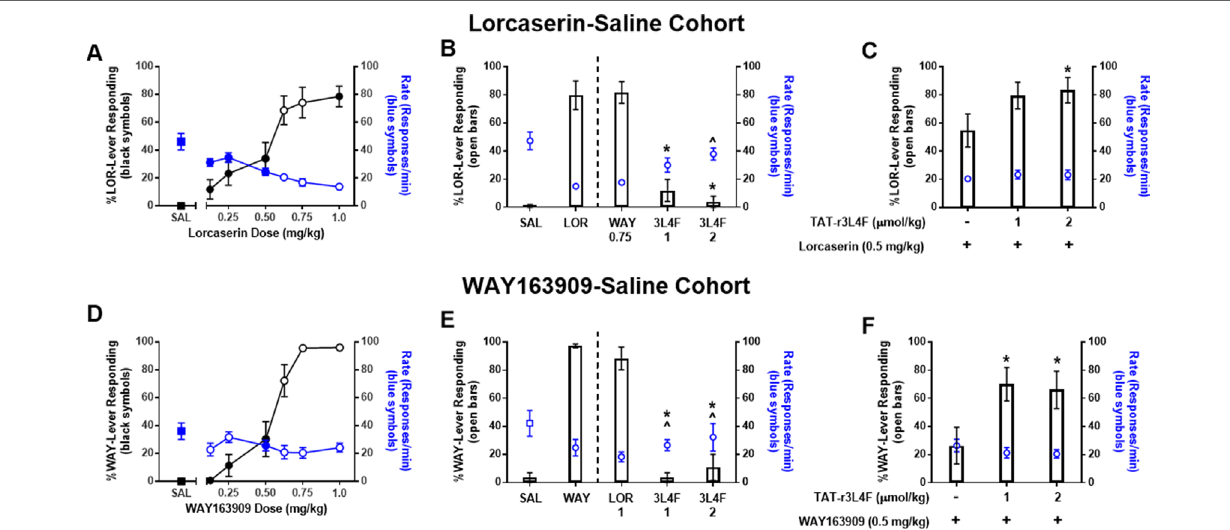
FIGURE 2 | Results of dose–response tests in (top) rats (n = 14) trained to discriminate lorcaserin (LOR; 0.75 mg/kg) from saline and (bottom) rats (n = 7–13) trained to discriminate WAY163909 (WAY; 0.75 mg/kg) from saline (SAL). Black symbols denote the mean ( ± SEM) percentage of drug-lever responding; blue symbols denote the mean ( ± SEM) response rate per minute. For comparison, the percentage of drug-appropriate responding and response rate observed after saline tests are included (squares). Closed symbols indicate p < 0.05 vs. previous drug maintenance session. (A-C) Results of WAY163909 (WAY; 0.75 mg/kg), lorcaserin (LOR; 0.5-1 mg/kg), and TAT-r3L4F (3L4F; 1, 2 μ mol/kg) substitution or combination tests in lorcaserin–saline-trained rats. * p < 0.05 vs. % lever response for LOR (0.5 mg/kg) alone. ^ p < 0.05 vs rate of response for LOR (0.5 mg/kg) alone. For comparison, the percentage of drug-appropriate responding and response rate observed after training drug (0.75 mg/kg) and saline (SAL) are presented left of the dashed line. (D-F) Results of WAY163909 (WAY; 0.5-0.75 mg/kg), lorcaserin (LOR; 1 mg/kg), and TAT-r3L4F (3L4F; 1, 2 μ mol/kg) substitution or combination tests in WAY163909–saline-trained rats. * p < 0.05 vs. previous % lever responses of drug maintenance session. ^ p < 0.05 vs. previous rate of responses of drug maintenance session. Bars represent the mean percentage of drug (lorcaserin: LOR; WAY163909: WAY)-lever responding ( ± SEM) observed during test sessions. Blue symbols represent rate of